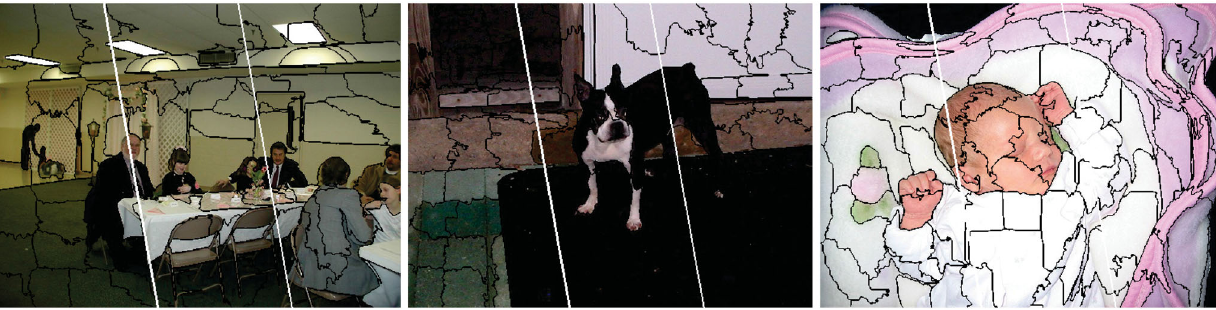
Fig. 14 Images from the Pascal Context dataset segmented by our proposed approach with m = 10, 20, and 30, respectively. When m is smaller, the superpixels follow boundaries well. When m is larger, the superpixels are more